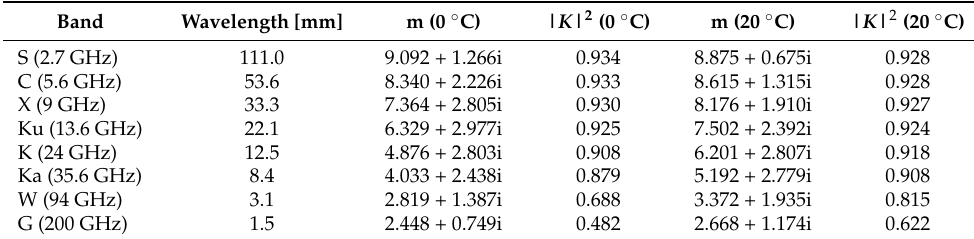
Table 2. Wavelength dependent complex dielectric constant m and squared water dielectric constant | K | 2 at 0 ◦ and 20 ◦ C that are needed as inputs to the PyTmatrix module. Additional non-wavelength dependent input parameters needed for the PyTmatrix module include: raindrop spherical diameters from 0.02 to 9.02 mm in 0.02 increments, raindrop obliqueness relationship of Equation (2), and simulations performed at vertical